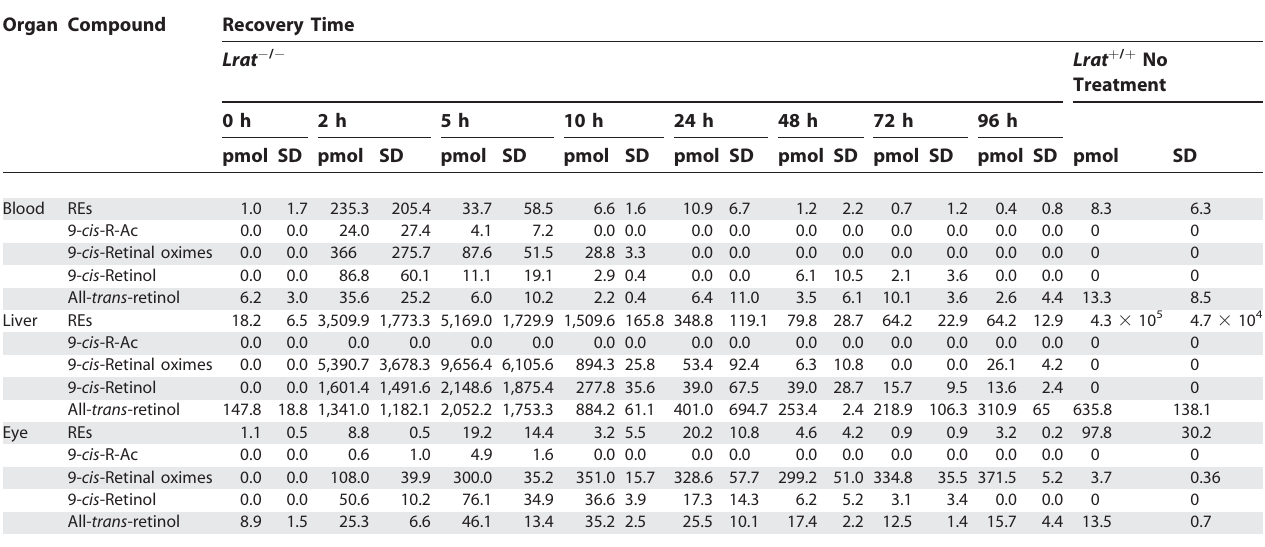
Table 1. Retinoid Analysis of Tissues from Lrat (cid:2) / (cid:2) Mice Gavaged with 20 l mol 9- cis -R-Ac as a Function of Post-Treatment Time Organ